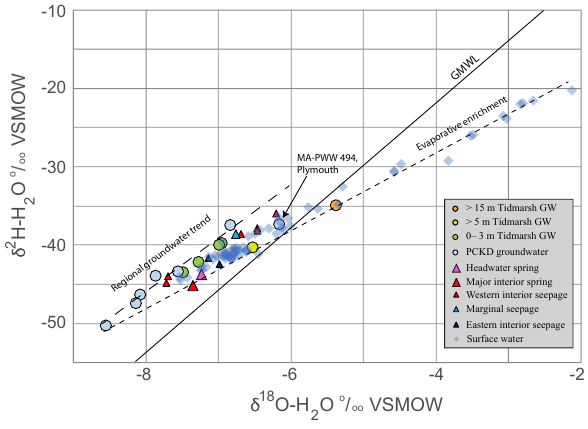
Figure 8. Plot of the stable isotopes ∂ 2 H-H 2 O and ∂ 18 O-H 2 O from the Tidmarsh Farms area surface water (diamonds), groundwater (circles), shallow well, and seep sources (triangles). The regional groundwater trend line was derived from samples from relatively shallow, regional USGS wells (blue dots), consistent with a rela- tively humid climate at the